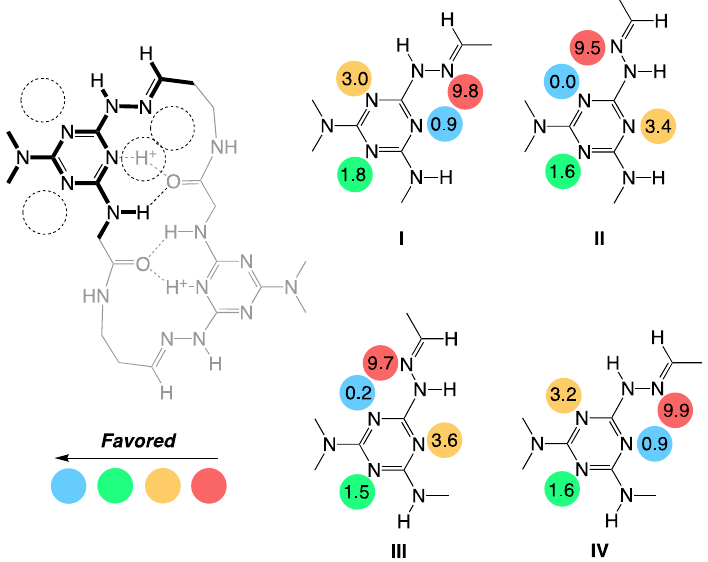
Figure 4. The relative energies of the protonated triazines in kcal/mol for the four rotamers arising from hindered rotation about the triazine-N bond. Color reflects the relative energetic differences with values reported in kcal/mol. See text for details. Dotted circles correspond to potential sites for protonation.